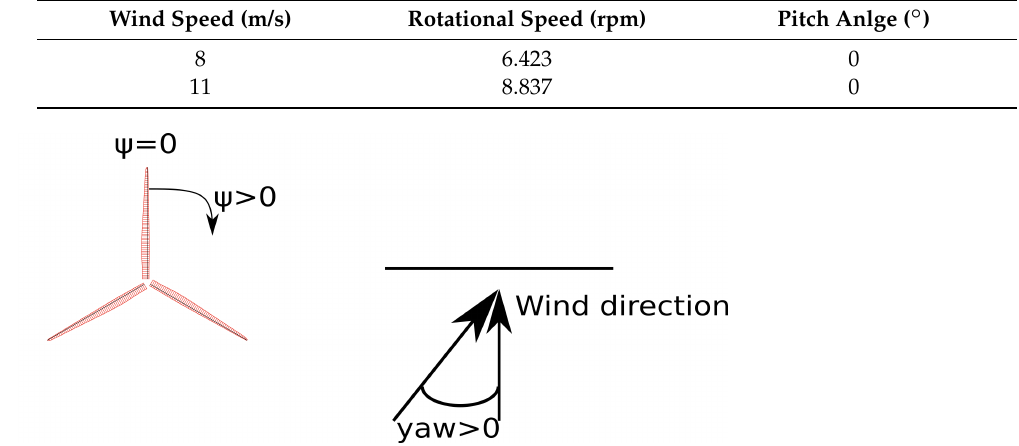
Figure A1. Horizontal axis wind turbine visualization. Table A2. BO105 free-stream flow data.